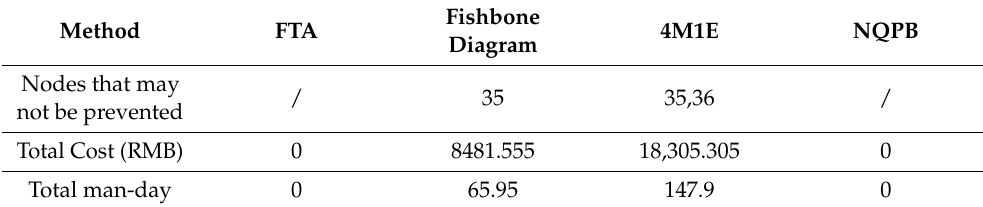
Table 9. Possible rework lifting costs and man-days for nodes 35 and 36 of the four methods. Fishbone Method FTA